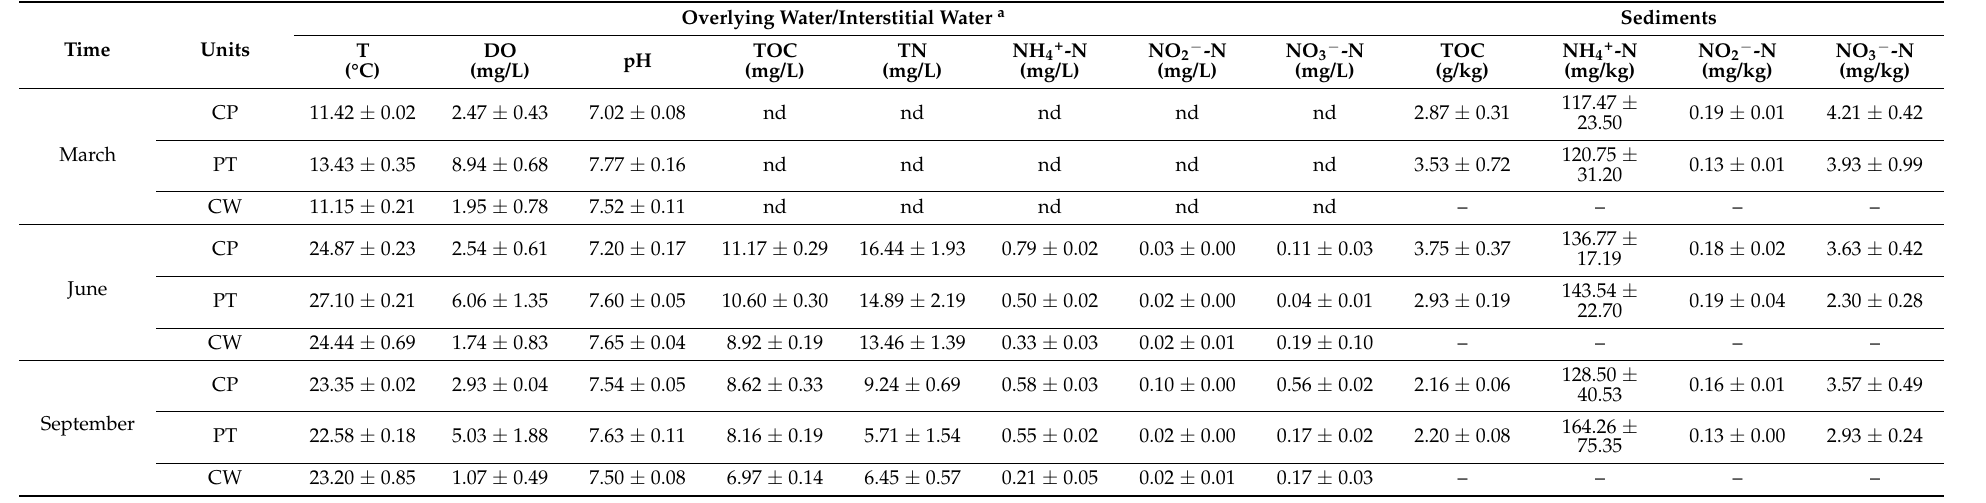
Table 1. Physicochemical characteristics of water and sediment samples from the